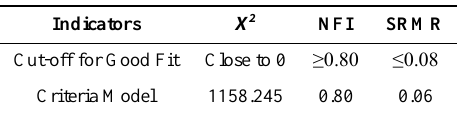
Table 5. Goodness of